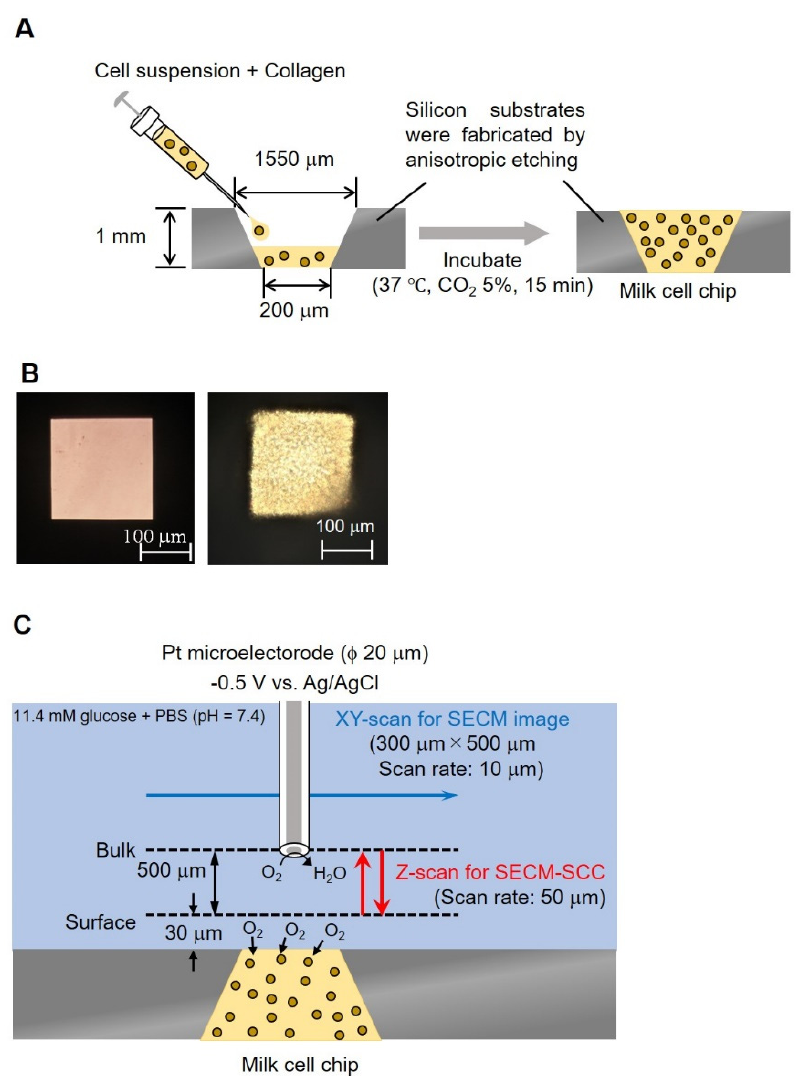
Figure 2. Conceptual diagram and photographs of milk cell chips. Schematic diagram of milk cell chips ( A ). Milk ( − ) and milk (+) ( B ). The experimental method of XY-scan and Z-scan ( C ). In the XY-scan, the distance between the microelectrode and the milk cell chip was set to 30 µ m or 160 µ m and scanned the range of 300 µ m × 500 µ m while applying − 0.5 V vs. Ag/AgCl. In the Z-scan, − 0.5 V vs. Ag/AgCl was applied to the Pt microelectrode. The working electrode was held 30 µ m above the top of the well and scanned 500 µ m in the Z direction to measure respiration activity. The scan rate was kept at 50 µ m/s; the number of scans was 3 and the sampling time was 100